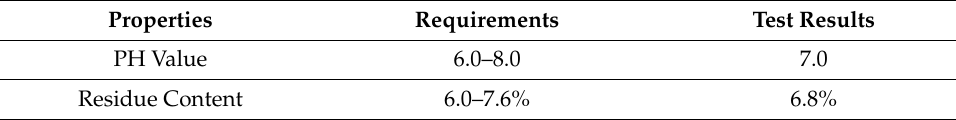
Table 6. Properties, requirements and test results for mixing